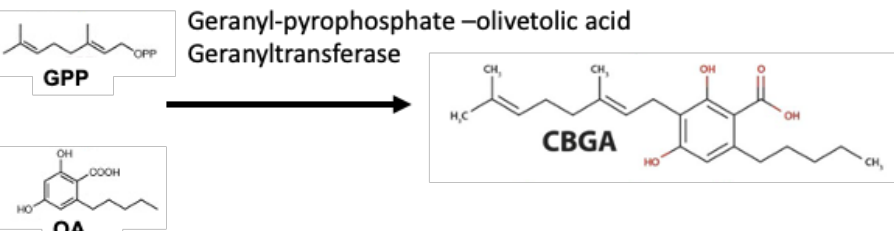
Figure 2. Cannabinoid biosynthesis begins with the combination of geranyl pyrophosphate (GPP) and olivetolic acid (OA) to form cannabigerolic acid (CBGA). CBGA serves as the substrate for phytocannabinoid synthesis.